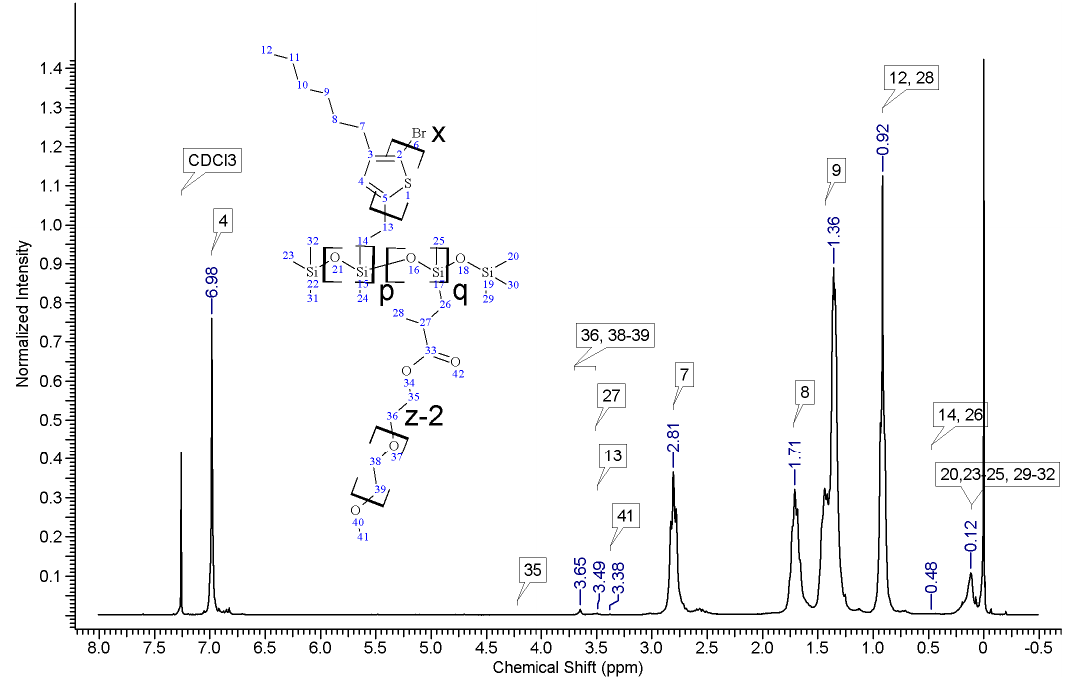
Figure A4. Spectrum of poly(methylsiloxane)-graft-[poly(3-hexylthiophene); poly(ethylene glycol)] (composed of chloroform fraction of vinyl terminated poly(3-hexylthiophene), poly(methylhydrosiloxane) average M n ≈ 390; chloroform fraction of graft copolymer) ( P3HT-Sil-PEG2 ).